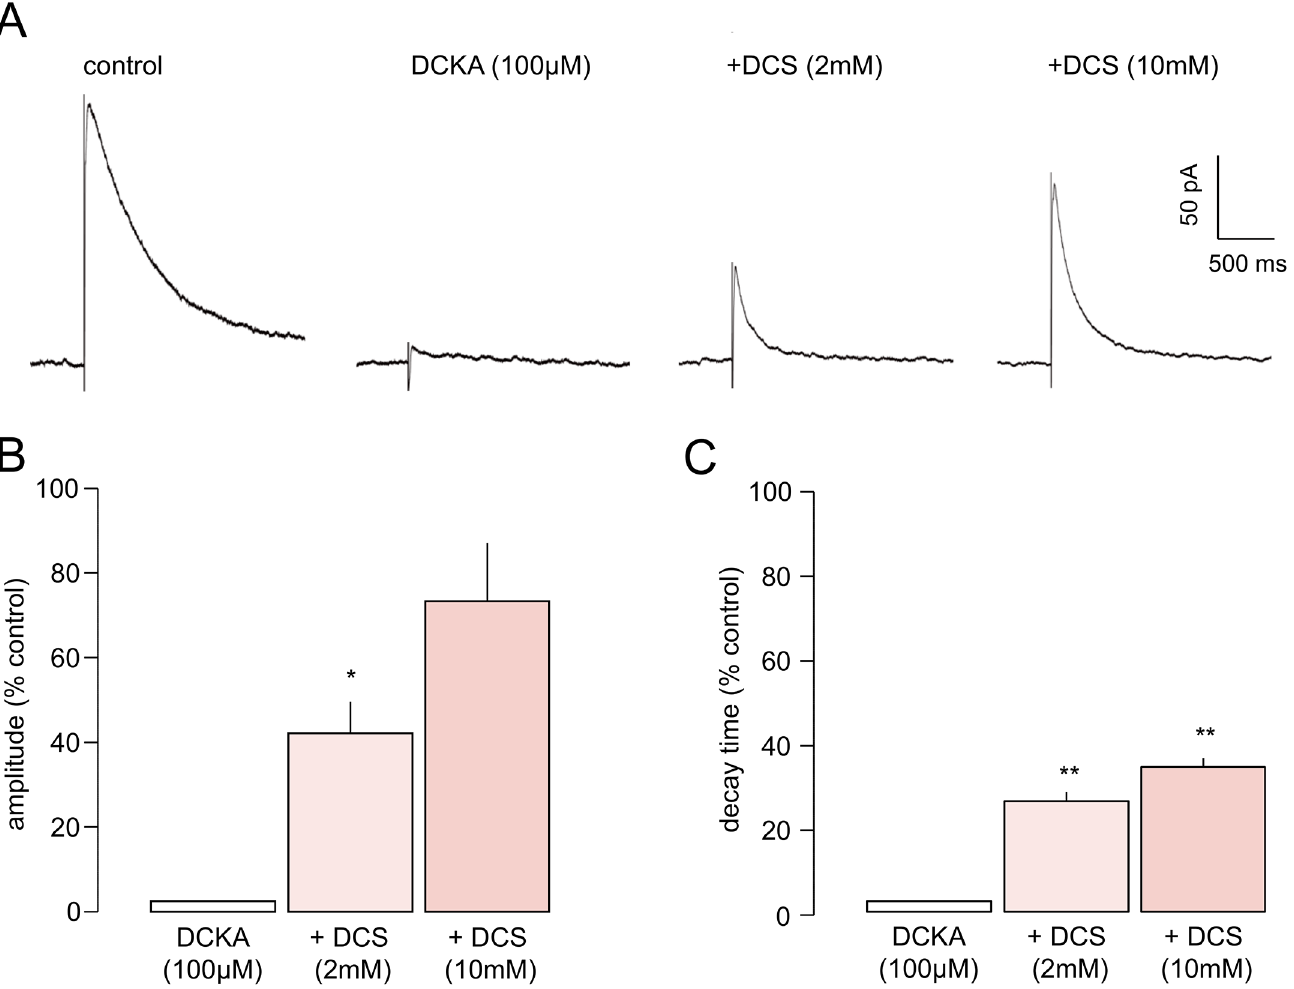
Fig 5. DCS rescues the abolition of the eNEPSC from inhibition by DCKA. A. Averaged synaptic responses from one neurone show abolition of the eNEPSC by the co-agonist site antagonist, DCKA. Subsequent addition of DCS at 2 mM partly restored the response; increasing the partial agonist concentration to 10 mM had a substantially greater restorative action. The histograms show the pooled normalised data for amplitude (B) and decay time (C) in 8 neurones. The restoration of the eNEPSC was partial, but it is noteworthy that the peak amplitude with DCKA plus DCS at 10 mM was not significantly different to that in control conditions. * P < 0.05; ** P <